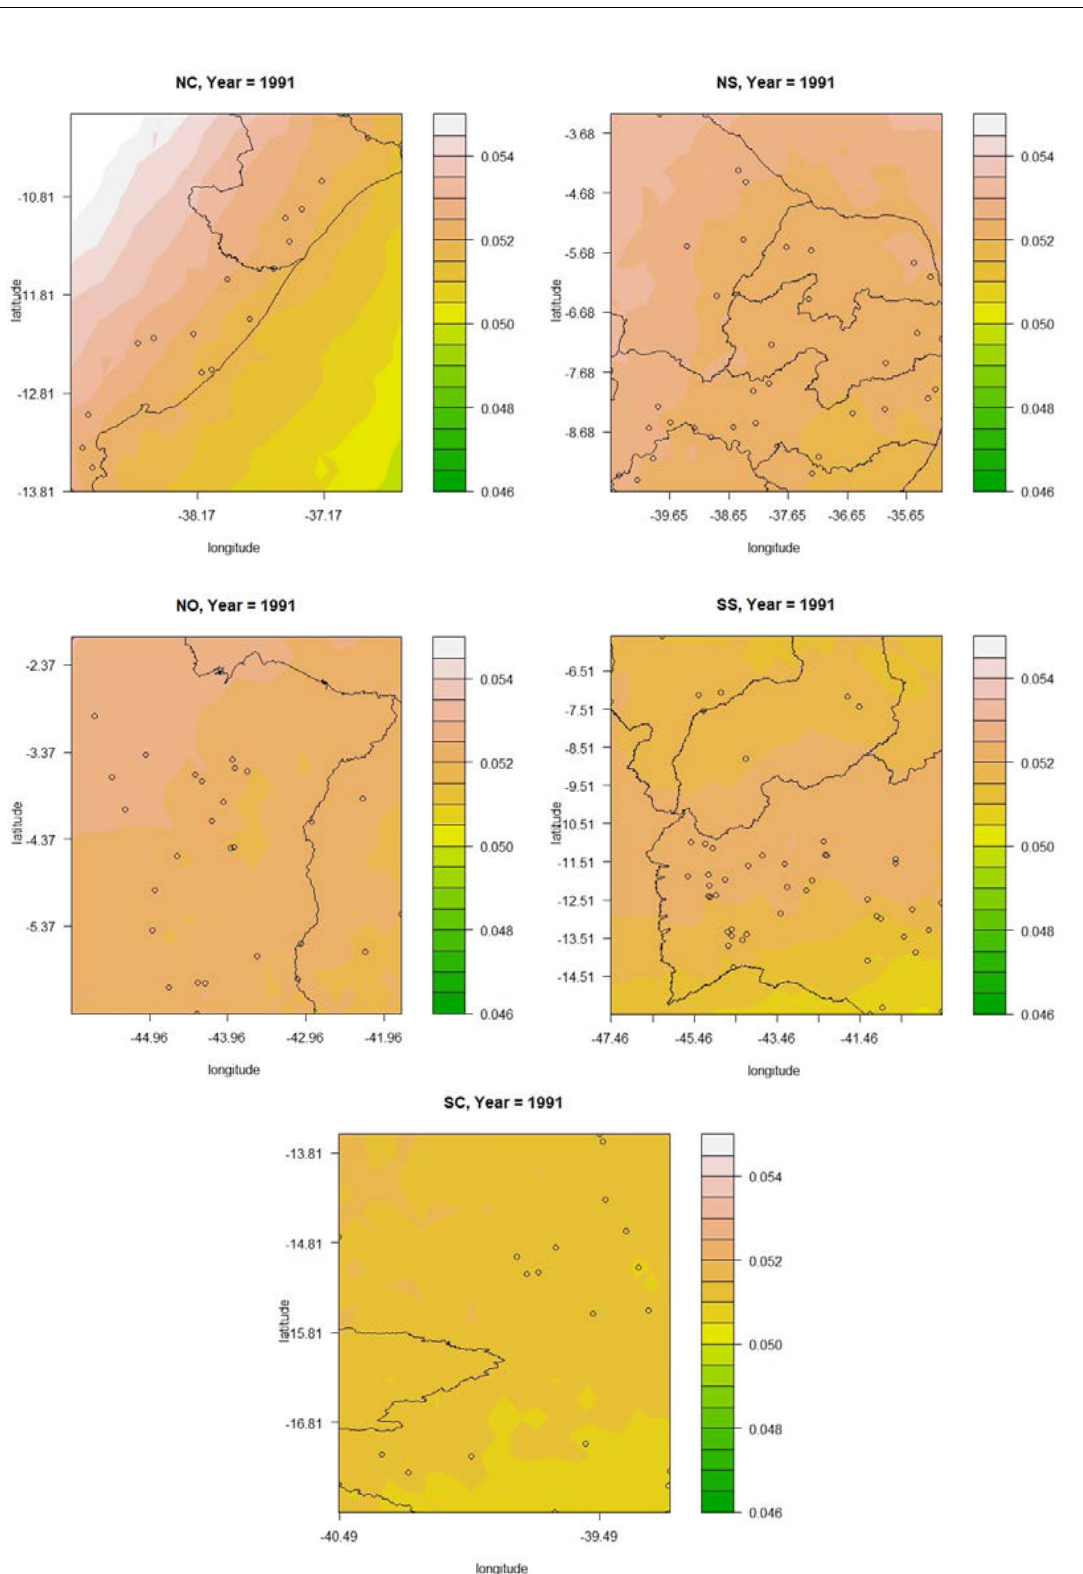
and is the 𝛽𝛽 , 𝛽𝛽 , 𝜙𝜙 , 𝜎𝜎 2 𝛹𝛹 2